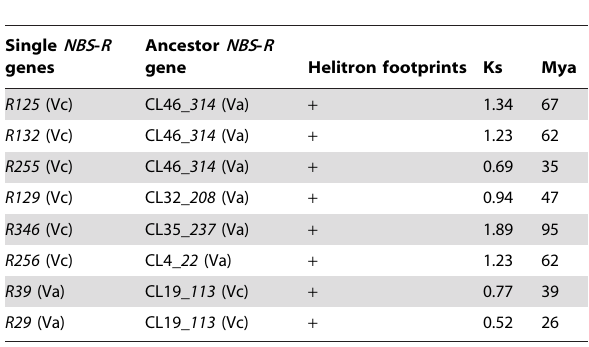
Table 2. Estimated time of transposition of NBS - R